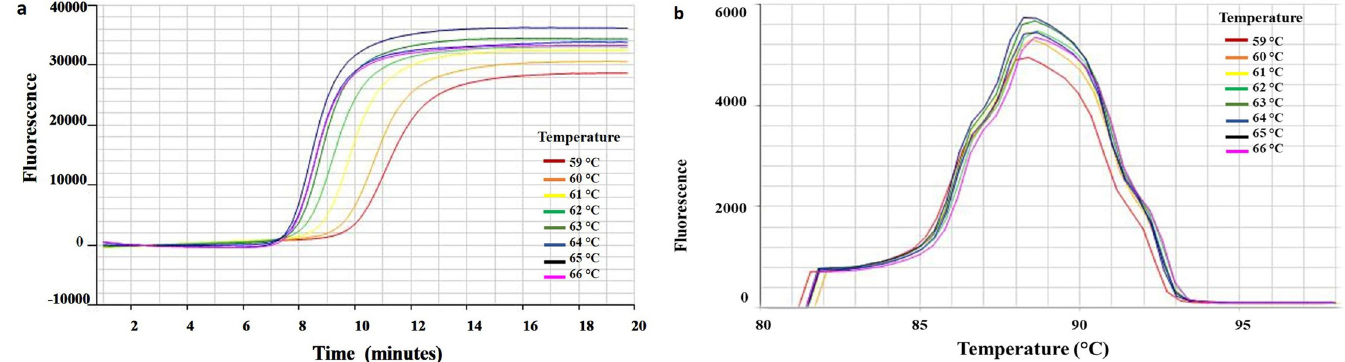
Fig 1. Amplification curves of thermal gradient RT-LAMP for optimizing annealing temperature for Citrus tristeza virus (CTV) VT isolate specific LAMP primers. (a) RT-LAMP reactions with an annealing temperature gradient ranged from 59˚C to 66˚C was set using the Genie III. CA-VT-AT39 RNA detection times were 11:00, 10:35, 9:40, 9:00, 8:35, 8:20, 8:15, and 8:25 (min:sec) at temperatures 59˚C, 60˚C, 61˚C, 62˚C, 63˚C, 64˚C, 65˚C, 66˚C, and 67˚C, respectively. (b) Melting curve of thermal gradient RT-LAMP primers of Citrus tristeza virus CA-VT-AT39 isolate after amplification for 20 min and detected on the FAM channel using 1˚C steps, and a hold of 30 sec at each step from 59 to 96˚C. The viral RNA had a melting temperature (Tm) of 88.4 ± 0.2˚C indicating similar sequences and amplicon size.